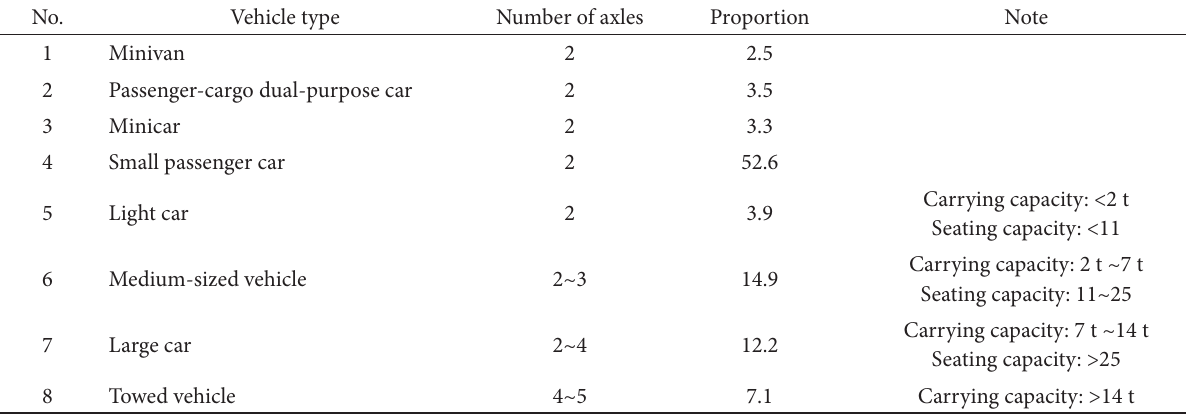
Table 2. Taffic survey on Guangfo highway